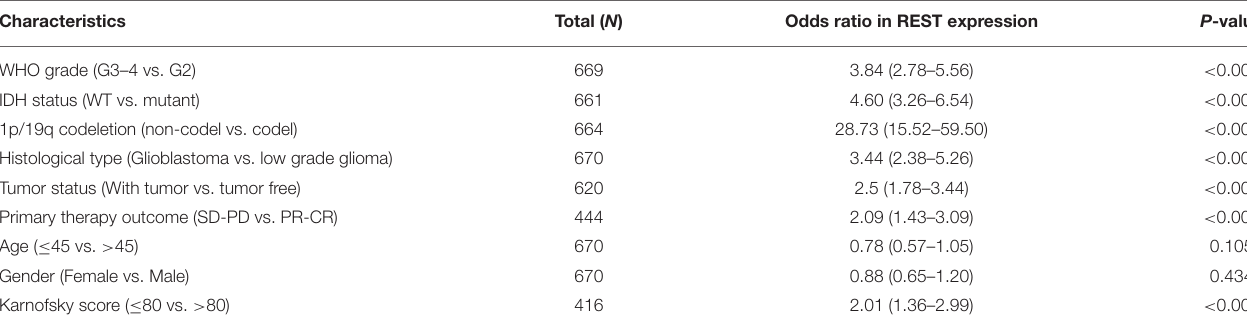
TABLE 2 | Logistic regression of clinical characteristics based on REST expression.